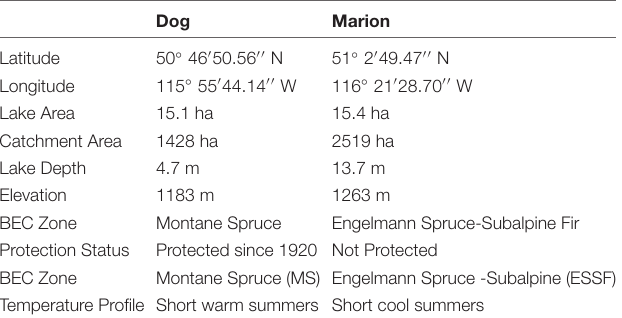
TABLE 1 | Dog and Marion Lakes characteristics